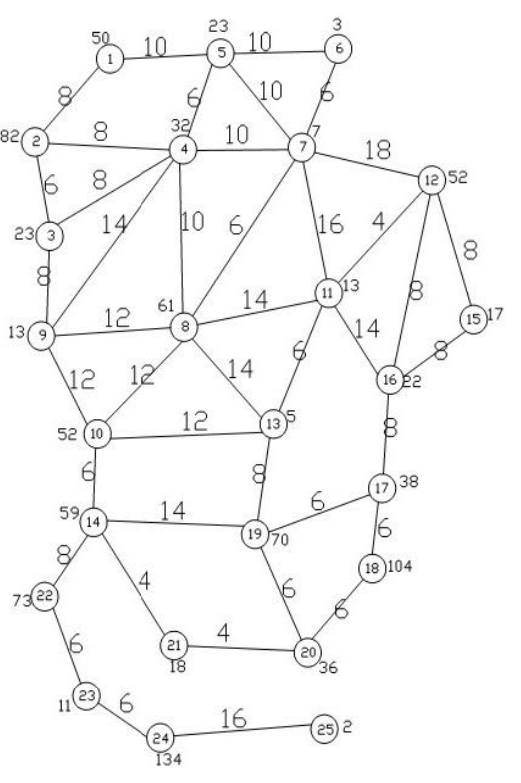
Fig.1 A 25-node Example Network